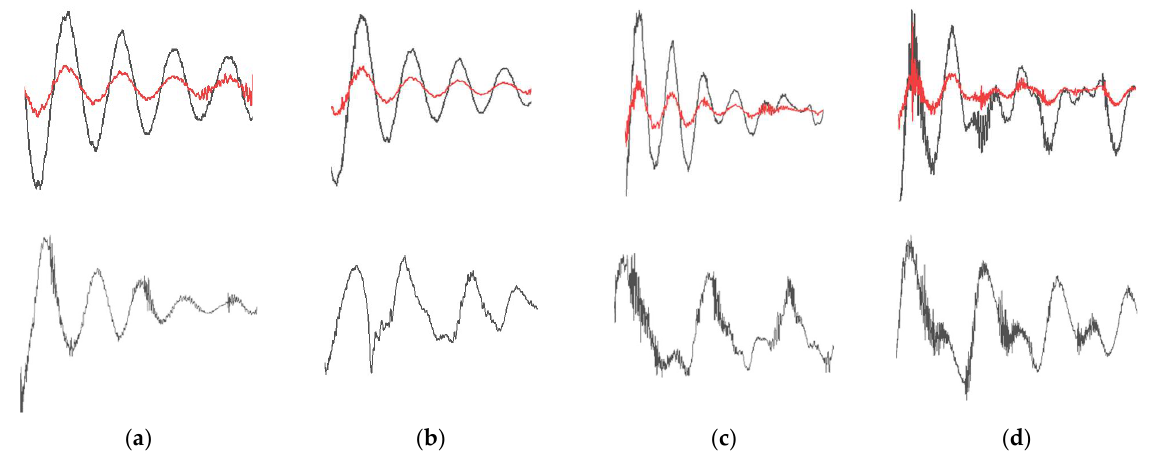
Figure 10. The changes in the forms of acceleration curves when the tank is placed on the top floor. ( a ) 2 cm; ( b ) 4 cm; ( c ) 6 cm; ( d ) 8 cm.